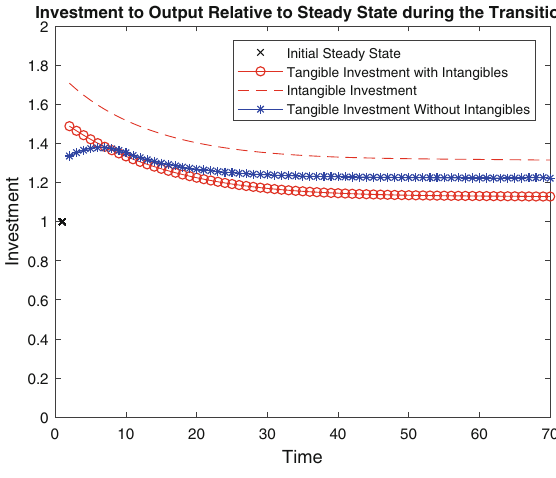
Fig. 5 Investment to output relative to initial steady state